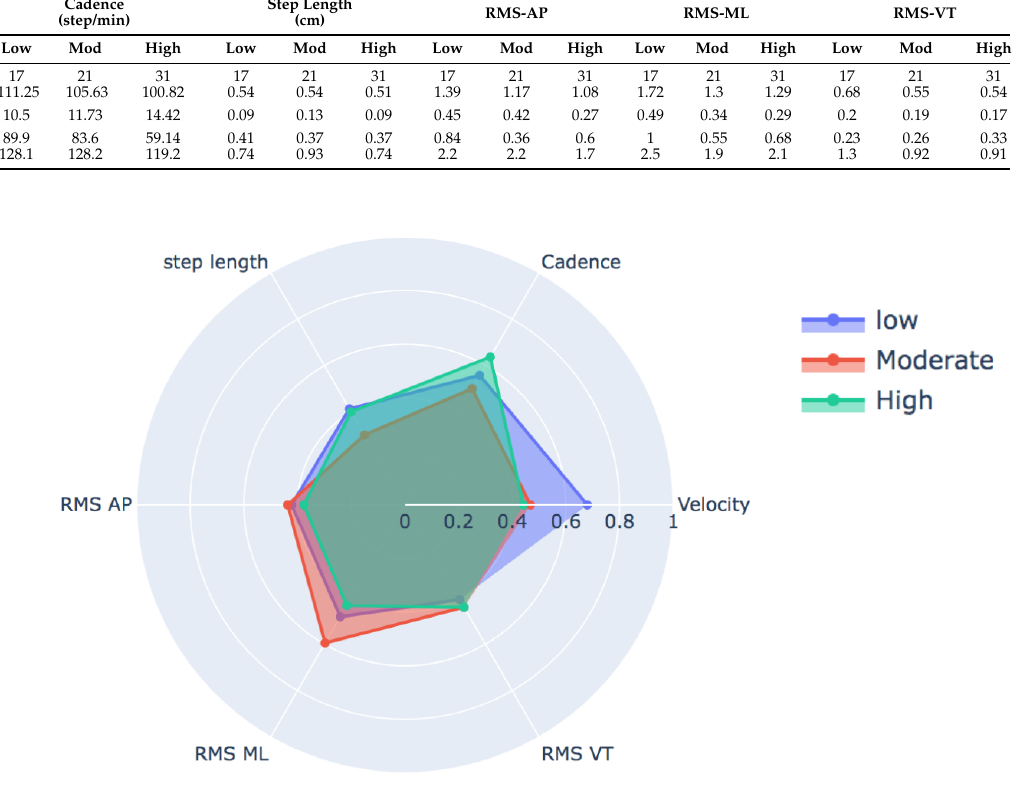
Table 4. Descriptive statistics of typically reported variables of acceleration patterns on gait. Descriptive Statistics